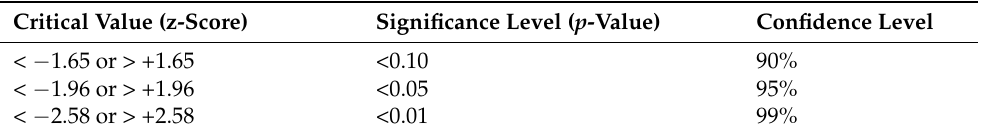
Table 2. Critical p -value and z-scores for different confidence levels. Critical Value (z-Score) Significance Level ( p -Value) Confidence